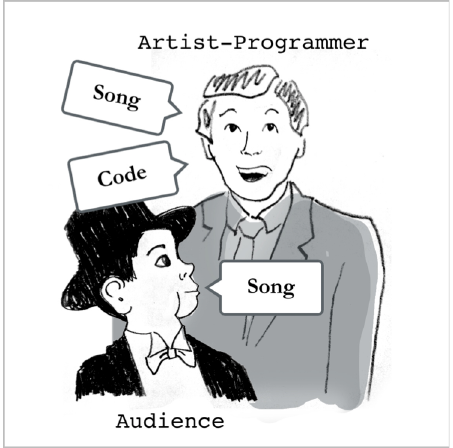
Figure 11 | “makeDummy” code. Figure 12 | Ventriloquisms for Fun and Profit